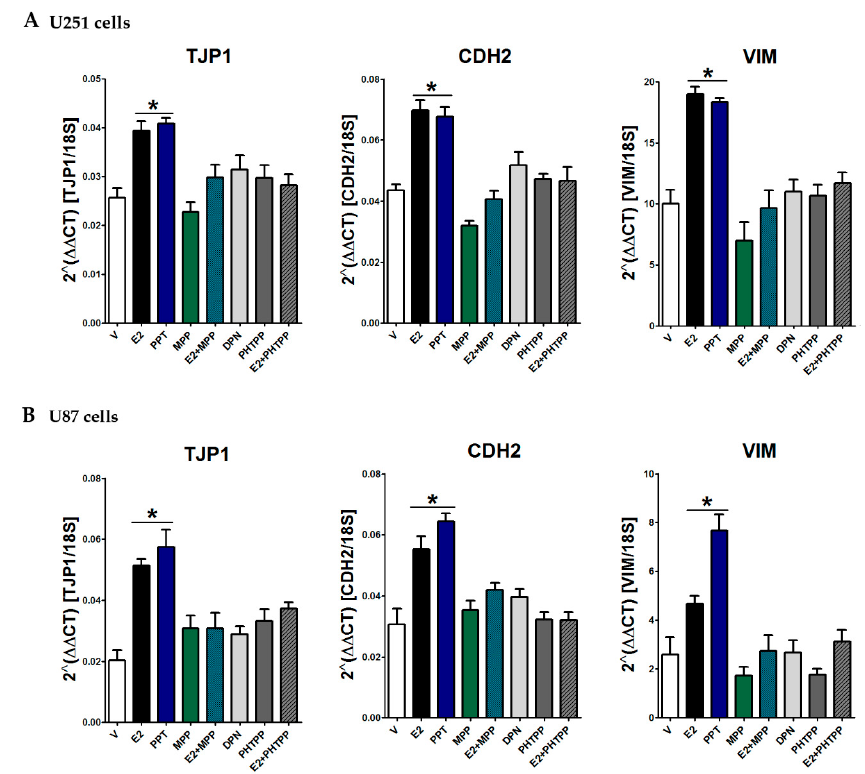
Figure 7. Effect of selective ER- α and ER- β agonists and antagonists on the EMT marker expression in GBM